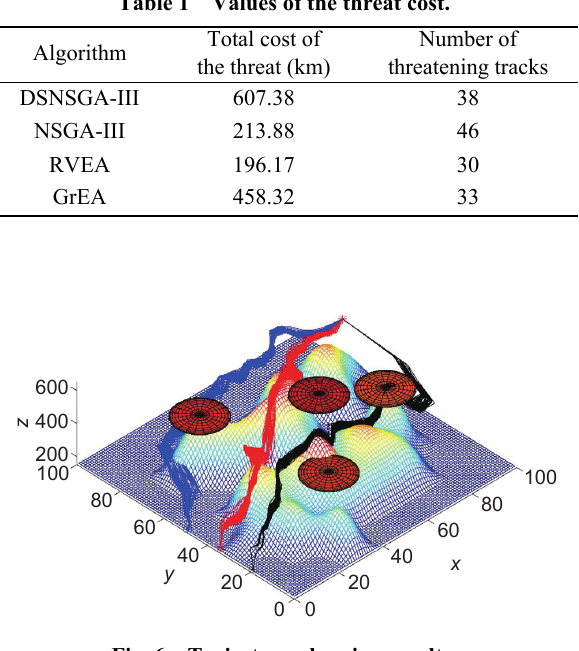
Fig. 6 Trajectory planning results.